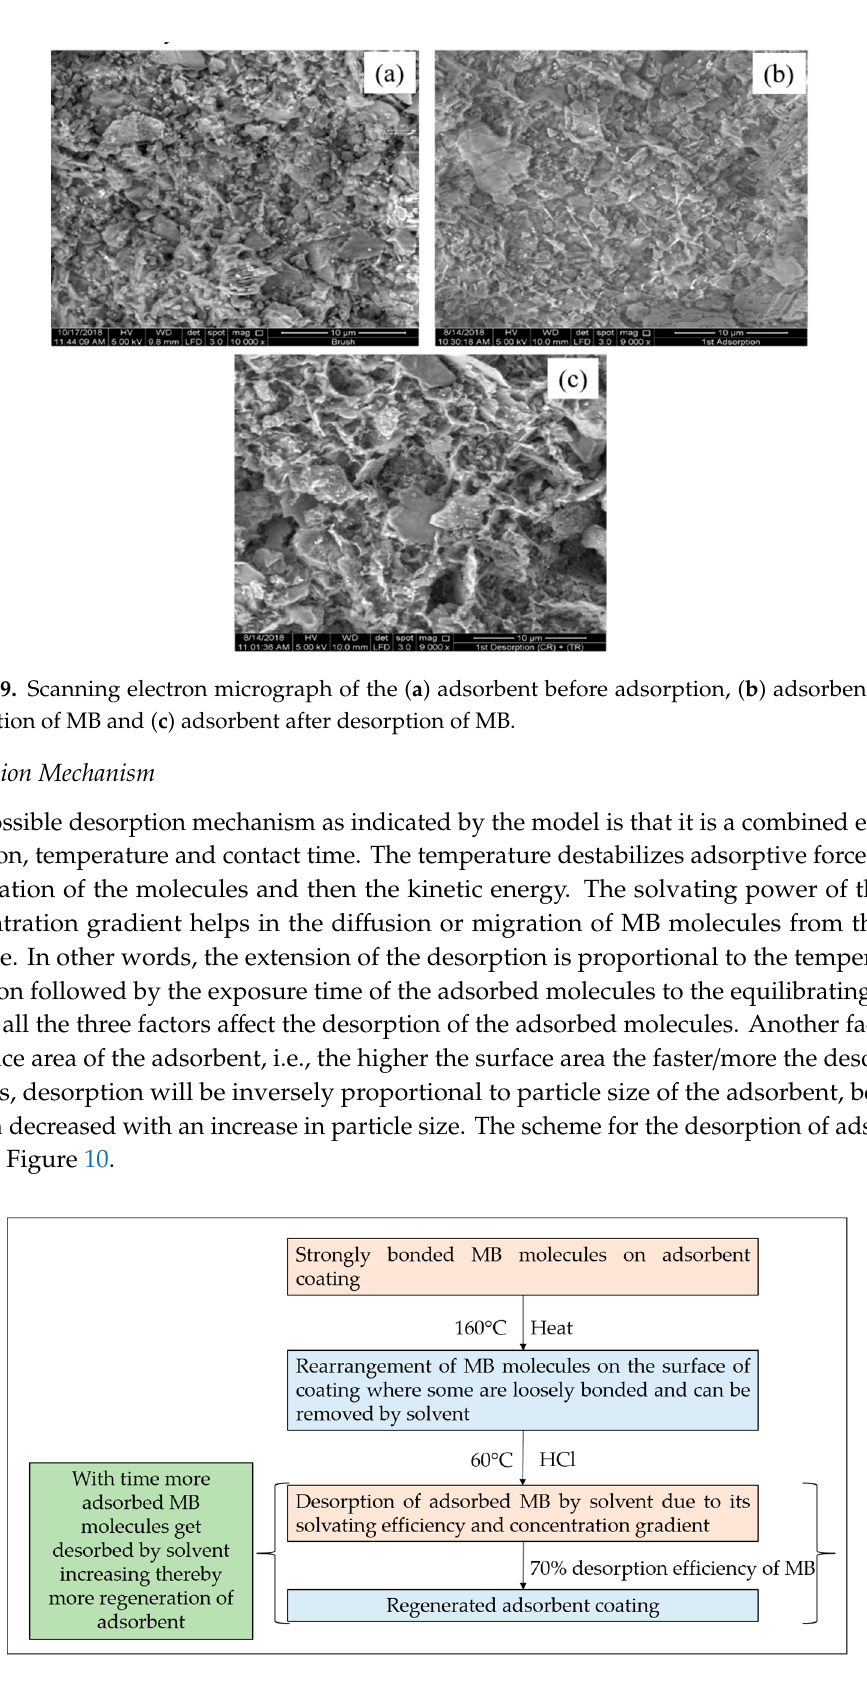
Figure 10. Mechanism scheme for the desorption of the adsorbed MB.